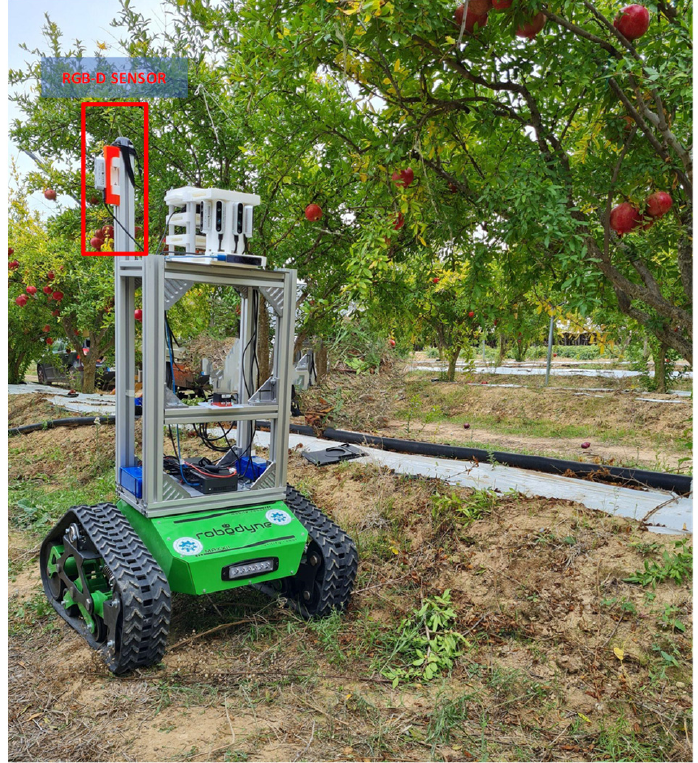
Figure 1. The farmer robot, Polibot, used for experimentation, equipped with a multi-sensor